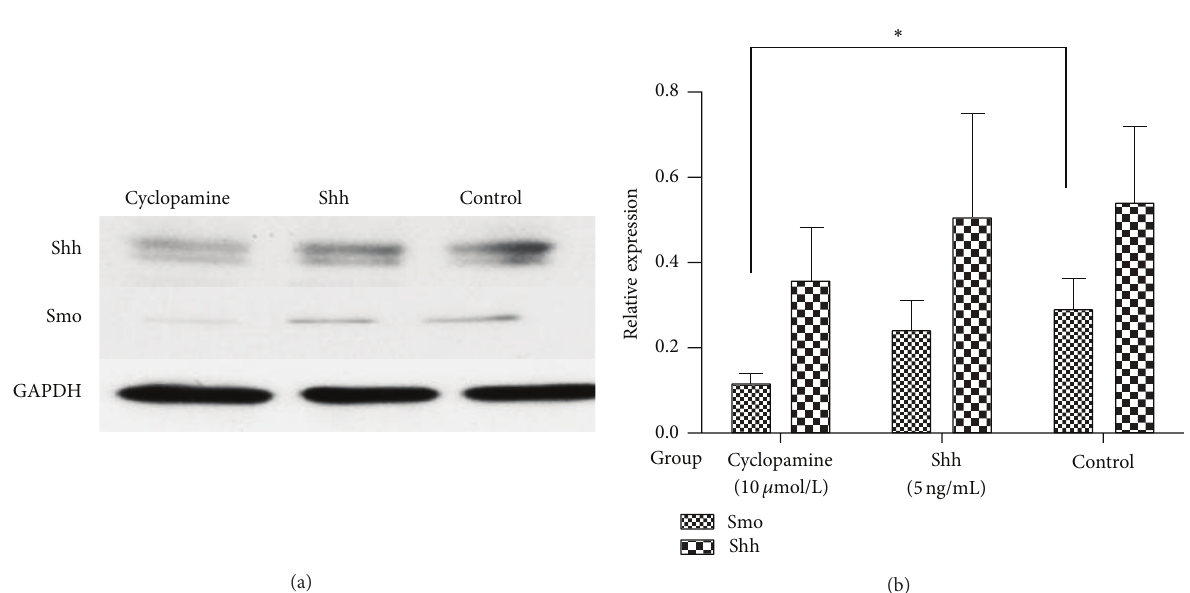
Figure 6: Cyclopamine decreased Shh and Smo protein expression in cultured RA FLS. Cells were stimulated, treated, and harvested as described in Section 2. Means ± S.D. of 3 independent experiments are shown. Expression of Smo and Shh was significantly lower in cyclopamine-treated FLS than in the control group ( 𝑃 < 0.05 ). There was no significant difference in Smo and Shh protein expression between Shh stimulated FLS and control cells. ∗ 𝑃 < 0.05 versus control